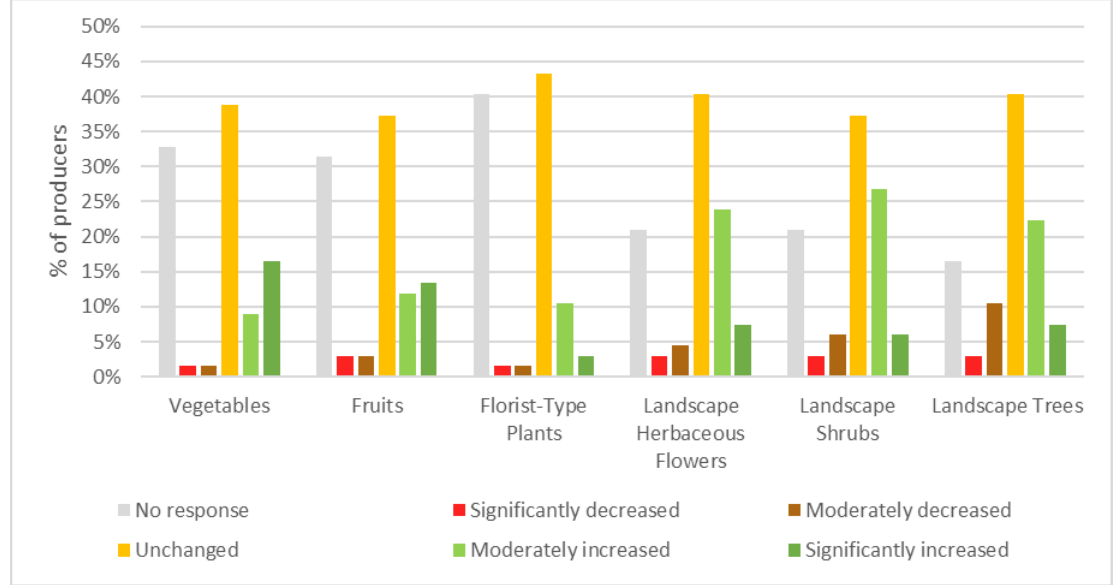
Figure 1. Percentage of producers who indicated change in purchases of plants during the pandemic, based on producer surveys.